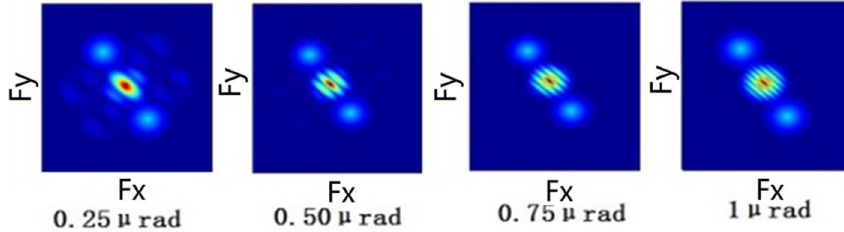
Figure 4. MTF for different tilt errors.